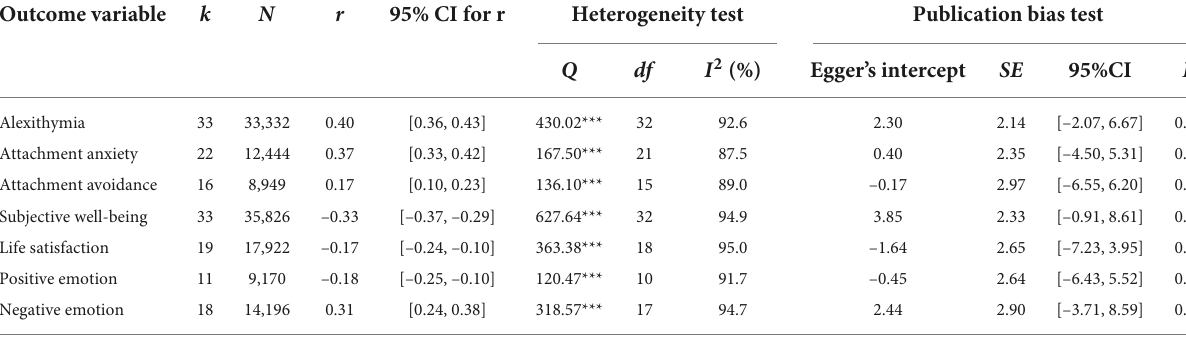
TABLE 2 Effect size and its heterogeneity test and publication bias test.